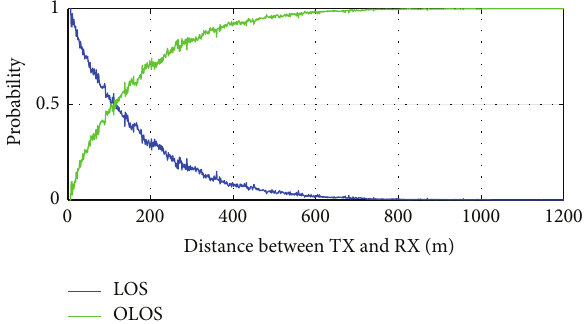
Figure 8: The probabilities of being in LOS and OLOS, respectively, depending on distance between TX and RX.